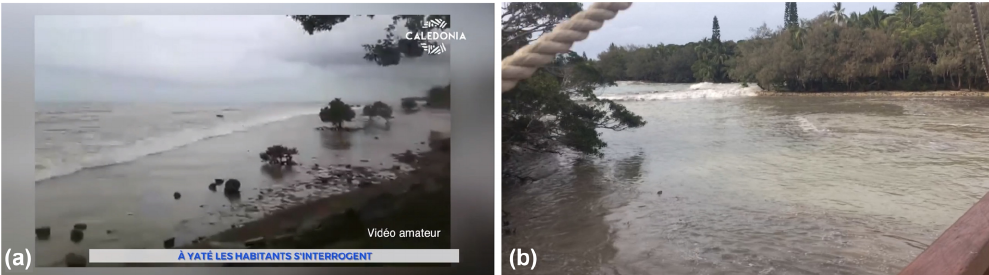
Figure 10. Arrival of the 5 December 2018 tsunami in (a) Yaté after the first withdrawal of the sea (courtesy of Rose-Mai Néa) and (b) at the bridge linking the Méridien resort island to the Isle of Pines (courtesy of Moana